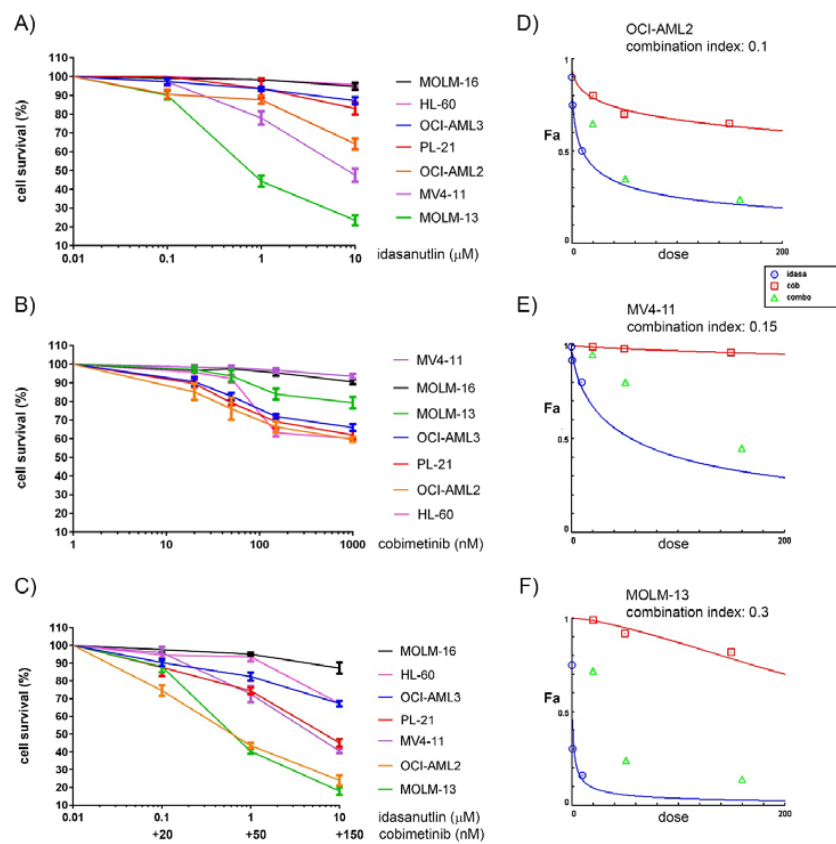
Figure 1. Sensitivity of AML cells to idasanutlin and cobimetinib. Cell viability in AML cell lines treated for 24 h with increasing dosages of idasanutlin ( A ) or cobimetinib ( B ) or in direct combination ( C ). Dose-effect curves in OCI-AML2 ( D ), MV4-11 ( E ) and MOLM-13 cells ( F ) treated with idasanutlin and cobimetinib alone or in combination. Fa indicates fraction of affected cells. Combination indexes were calculated on compusyn software (version 1.0; ComboSyn, Inc. Paramus, NJ, USA).